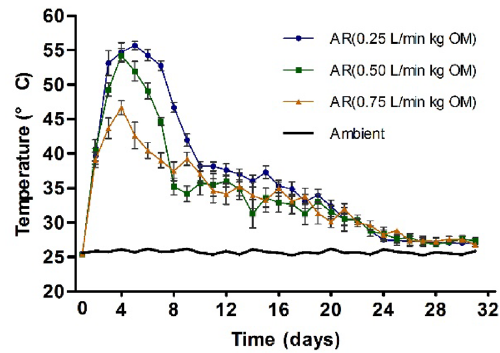
Fig. 2 Variations in temperature profiles during the composting pro‑ cess with three aeration rates